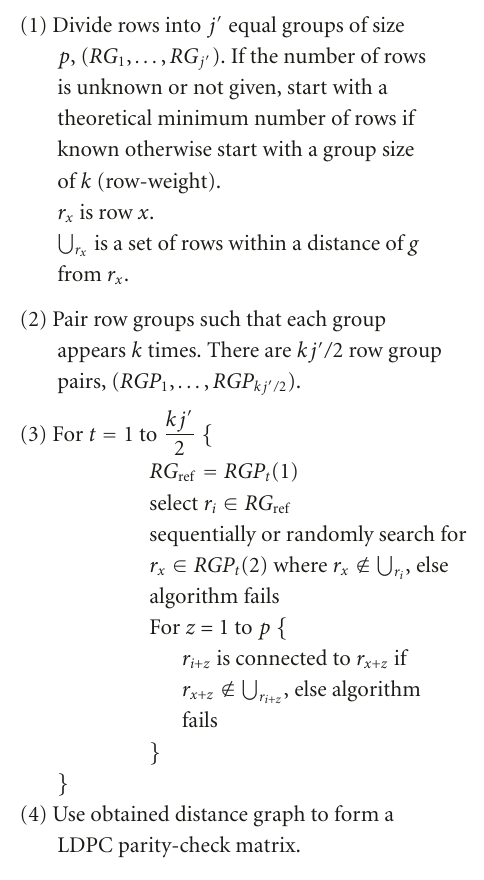
Figure 3: Matrix representation of a (16, 2, 4) code with girth eight.